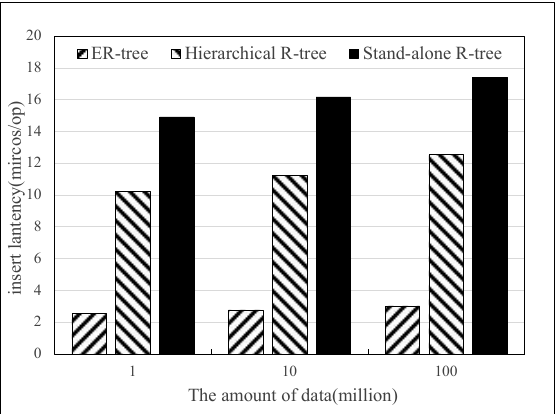
Figure 11. Comparison of the index insertion latency on the simulated datasets.